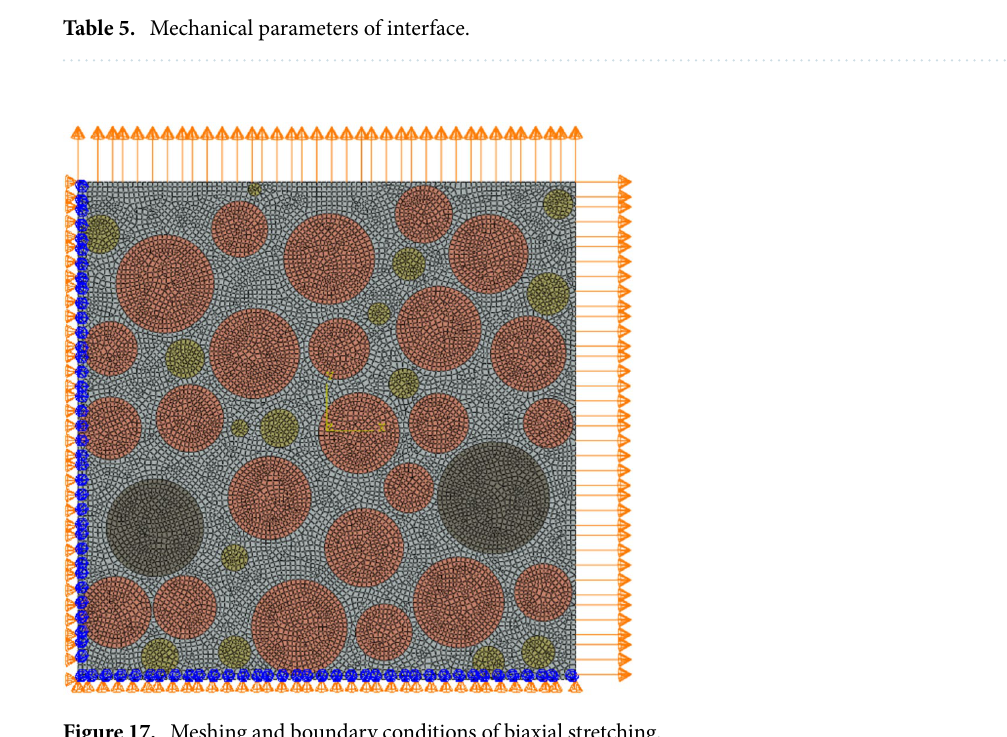
Figure 17. Meshing and boundary conditions of biaxial